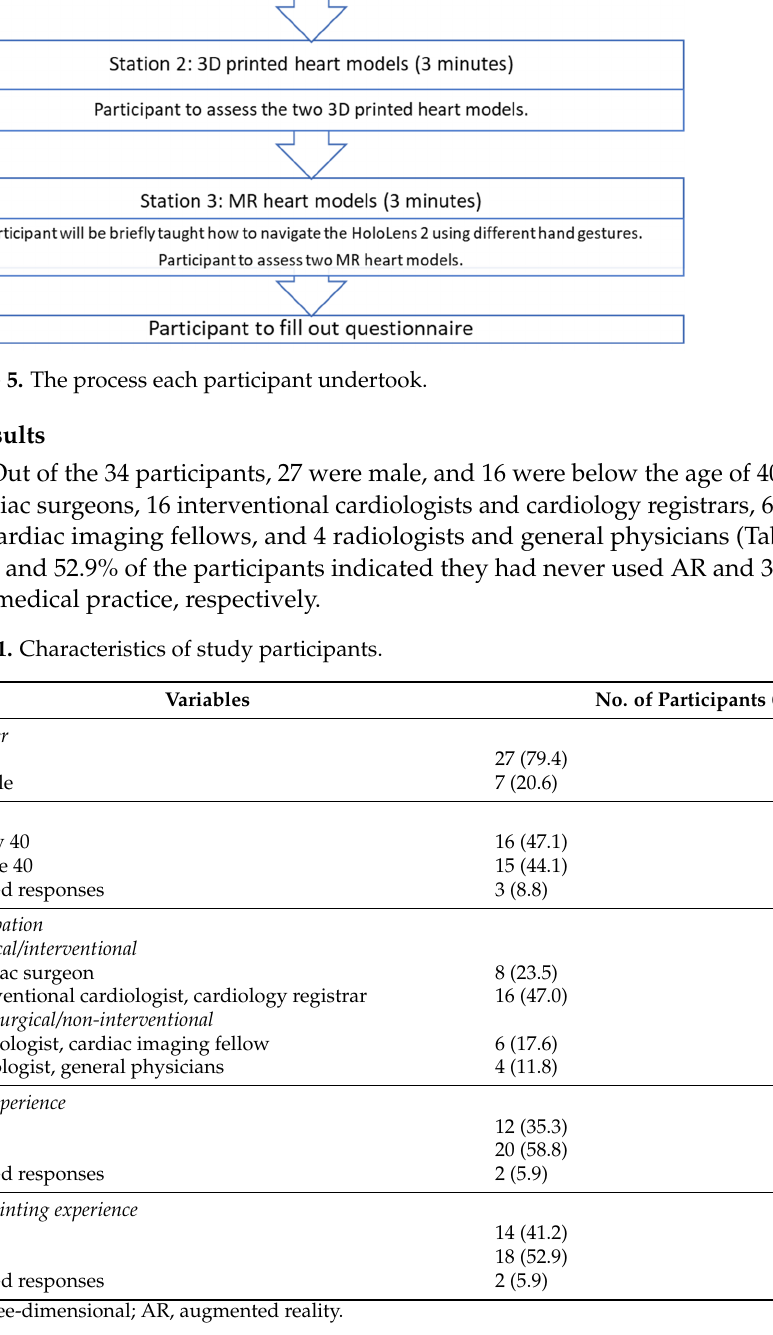
Table 1. Characteristics of study participants.